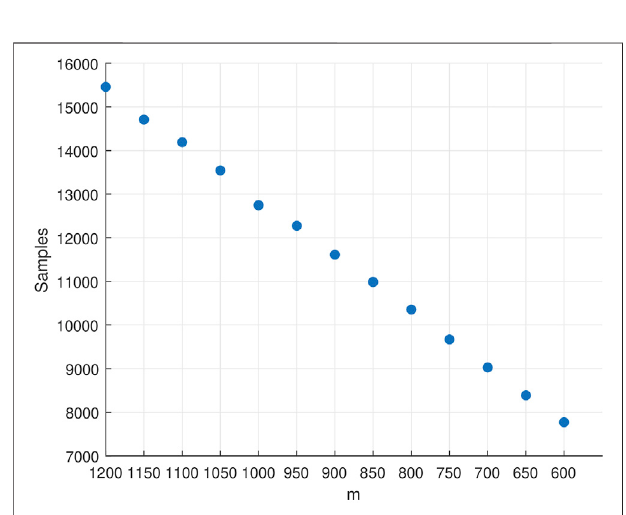
FIGURE 4 | The number of samples required by the Mormax